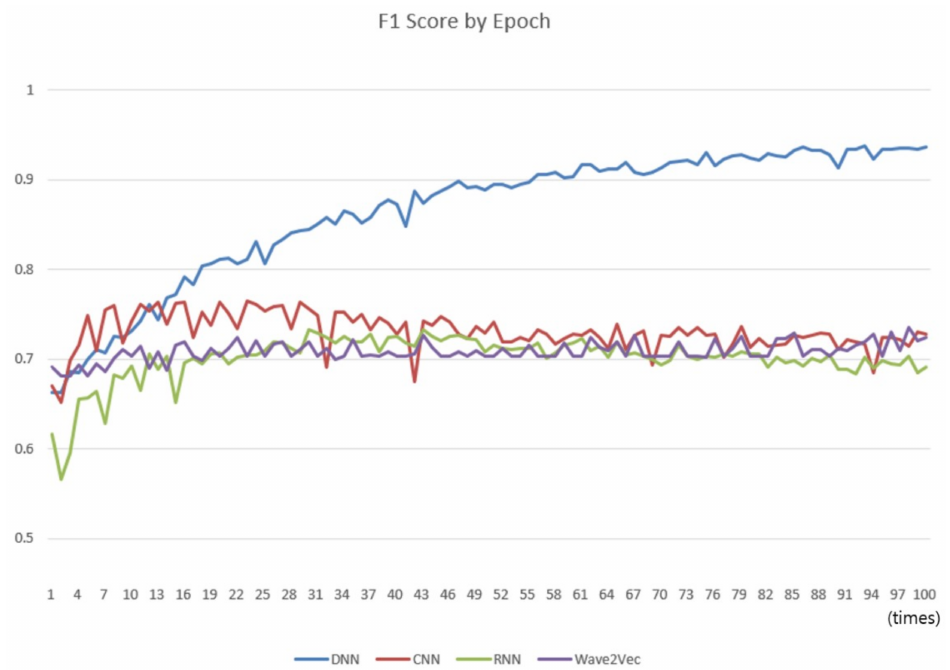
Figure 11. Comparison of the change of F1 scores of the four classifiers as the number of epochs varies from 1 to 100. The X-axis represents the number of epochs and y-axis represents score, whose scale is from 0 to